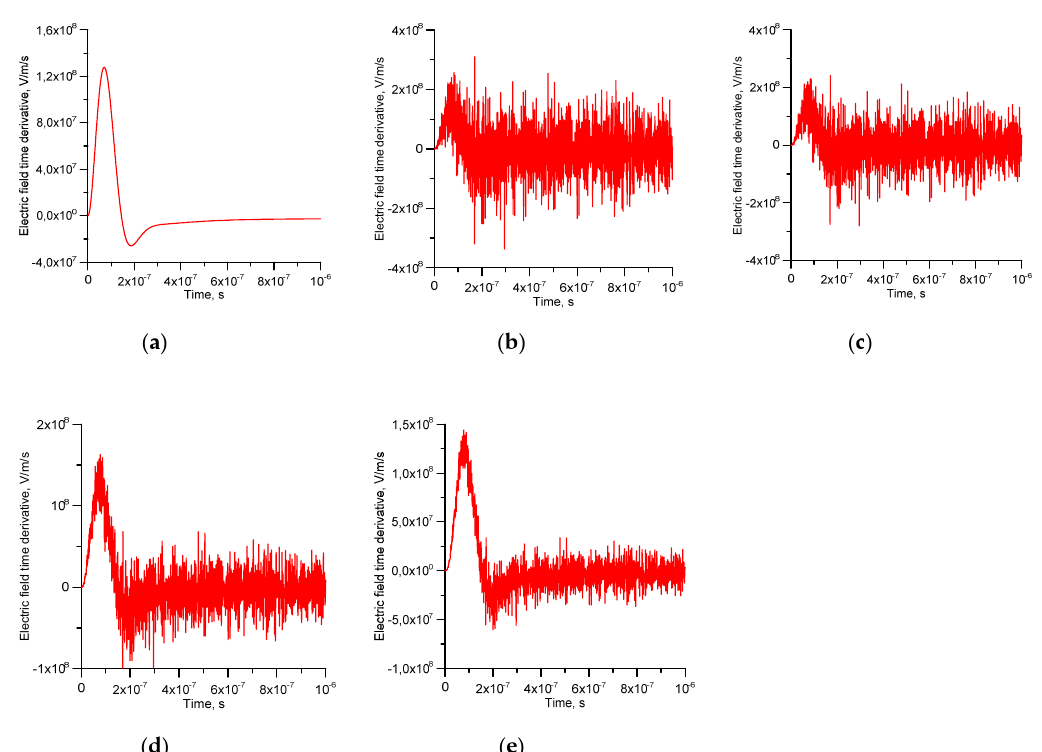
Figure 15. ( a ) Electric field time derivative without taking into account the randomness of the growth curve; ( b ) electric field time derivative taking into account the randomness of the growth curve; ( c ) ( d ) and ( e ) electric field derivatives measured with apparatus having risetimes of 1 ns, 5 ns, and 10 ns, respectively.